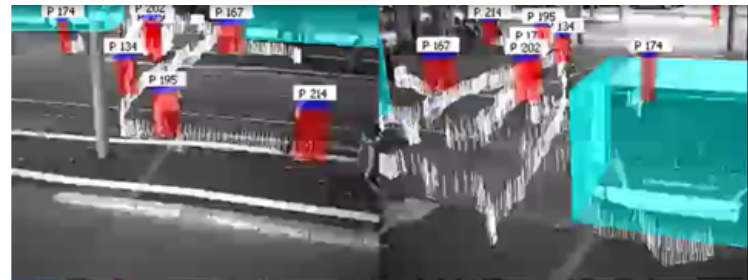
Figure 4: Visualization of a shared space traffic scene with augmented object